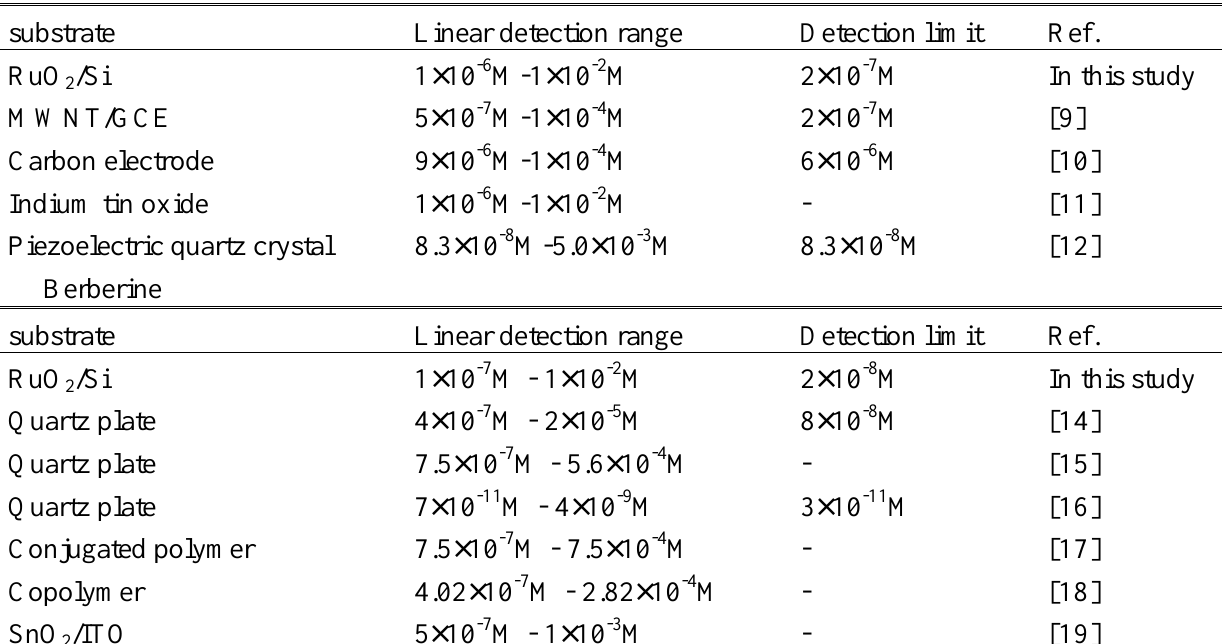
Table 1. Comparison of linear detection range and detection limit of procaine and berberine drug